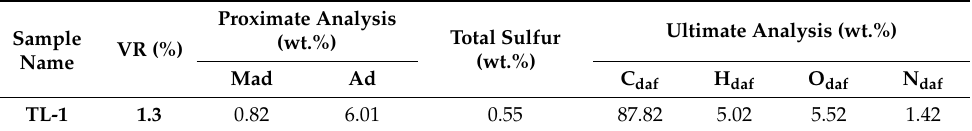
Table 1. Proximate analysis and element analysis of the TL-1 coal sample